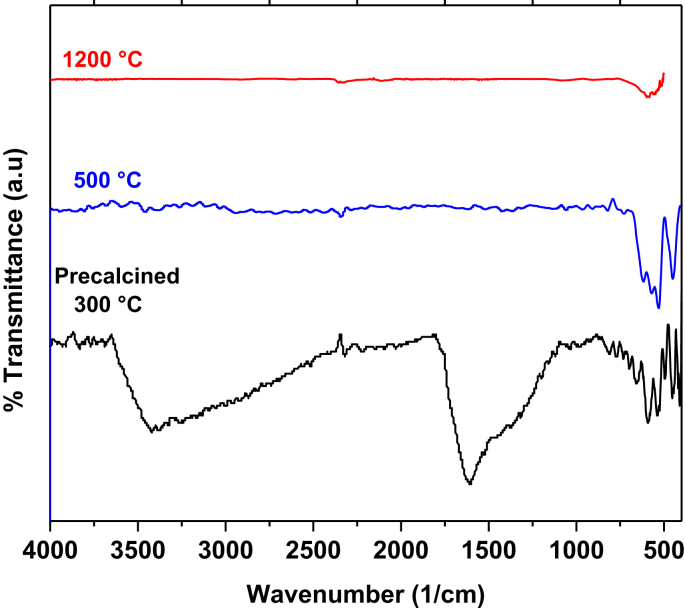
FTIR spectra of α-Fe2O3 samples heat treated at different temperatures.